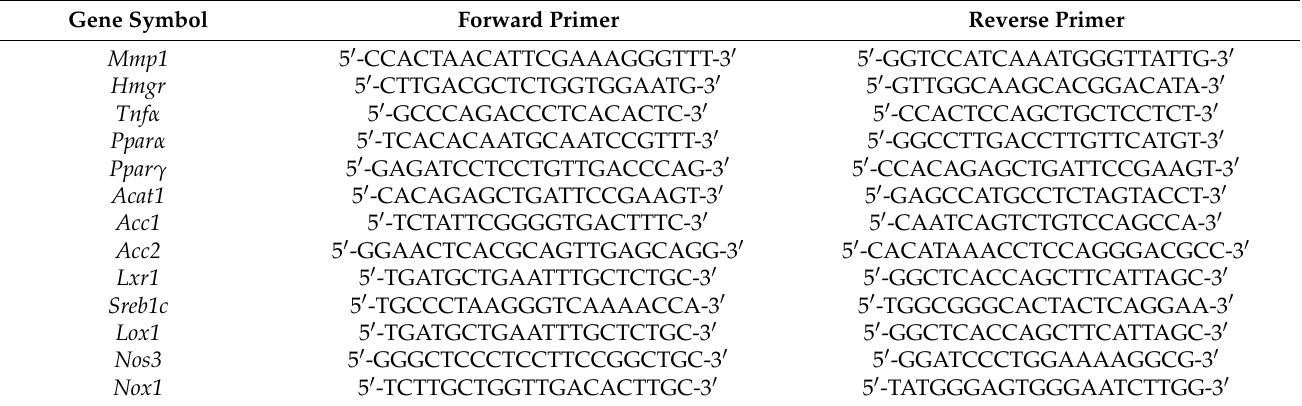
Table 9. Primer sequences. MMP1 , matrix metalloproteinase-1; HMGR , 3-hydroxy-3-methyl-glutaryl- coenzyme A reductase; TNF α , tumor necrosis factor alpha; PPAR α , peroxisome proliferator-activated receptor alpha; PPAR γ , peroxisome proliferator-activated receptor gamma; ACAT 1, acetyl-CoA acetyltransferase 1; ACC1 , acetyl-CoA carboxylase 1; ACC 2, acetyl-CoA carboxylase 2; LXR 1, liver X receptor; SREB1c , sterol regulatory element-binding protein 1; LOX1 , lectin-type oxidized